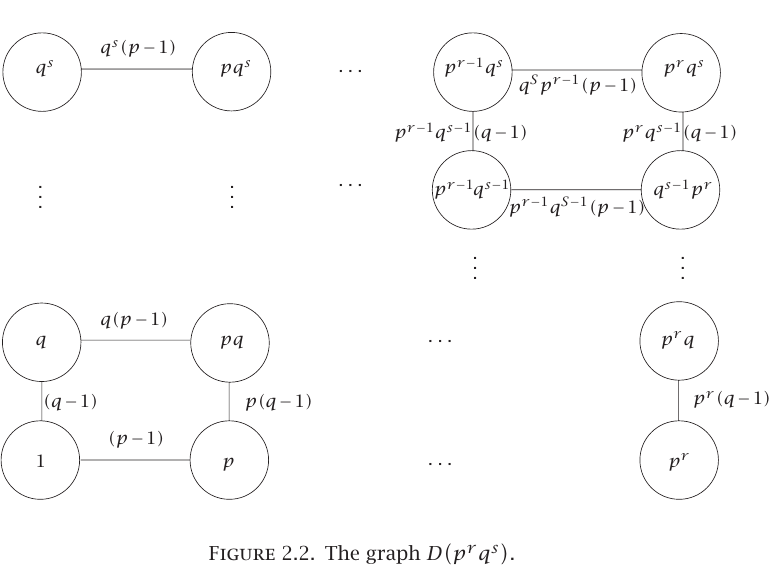
Figure 2.2 . The graph D